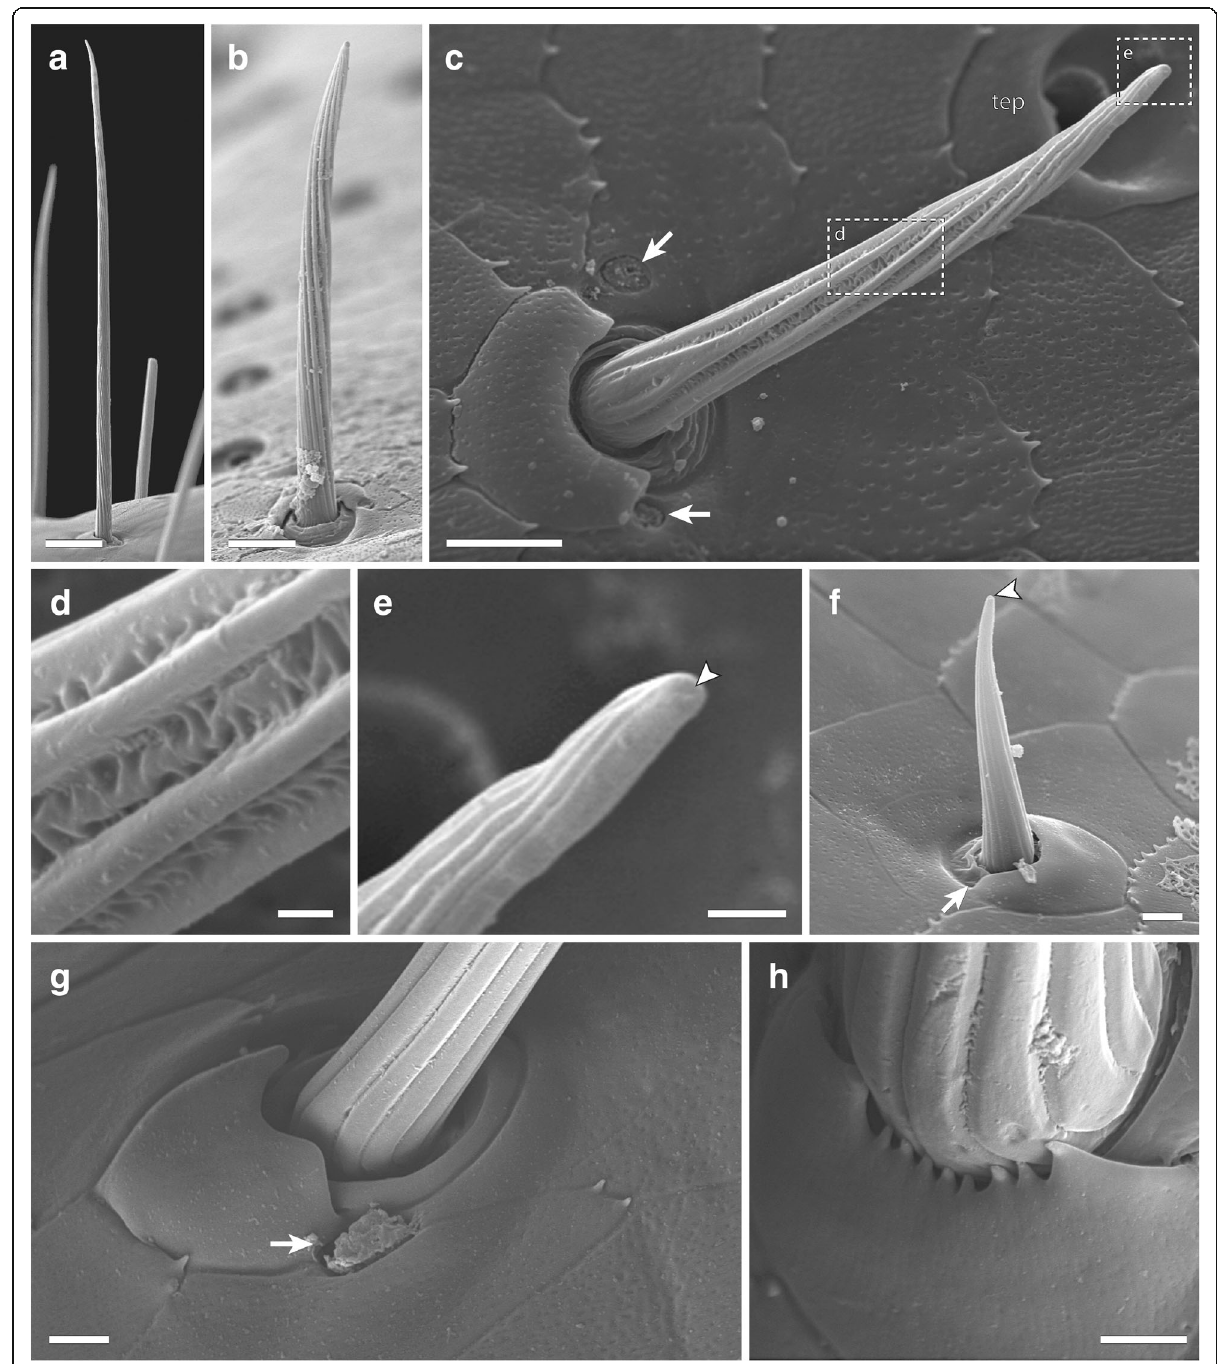
Fig. 6 Sensilla types on walking and ultimate legs. a Sensillum macrotrichodeum I. Note the orientation of the sensillum ’ s shaft nearly perpendicular to the cuticle. Scale bar 10 μ m. b Sensillum mesotrichodeum I. Scale bar 10 μ m. c Sensillum mesotrichodeum II. Note the association with two pores of solitary epidermal glands (arrows), and the characteristic appearance of the shaft. Scale bar 5 μ m. d Detail on the sensillar shaft as indicated in c illustrating the sponge-like cuticle between the ribs. Scale bar 500 nm. e Apex of s. mesotrichodeum II featuring a small terminal pore (arrowhead). Scale bar 1 μ m. f Sensillum microtrichodeum with terminal pore. Scale bar 2 μ m. g Crescent shaped socket of s. macrotrichodeum I. The sensillum is accompanied by a single glandular pore. Scale bar 2 μ m. h Close up on multidentate socket of s. macrotrichodeum II. Scale bar 2 μ m. Abbreviations: tep telopodal gland